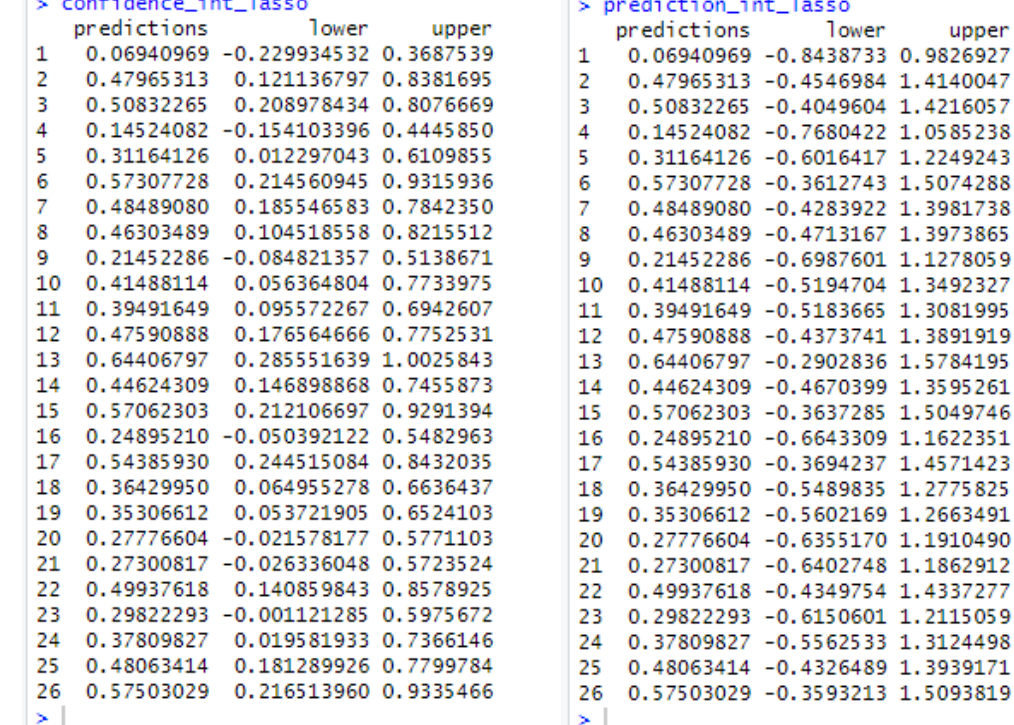
Figure 6. Confidence and prediction intervals for lasso regression predicted values